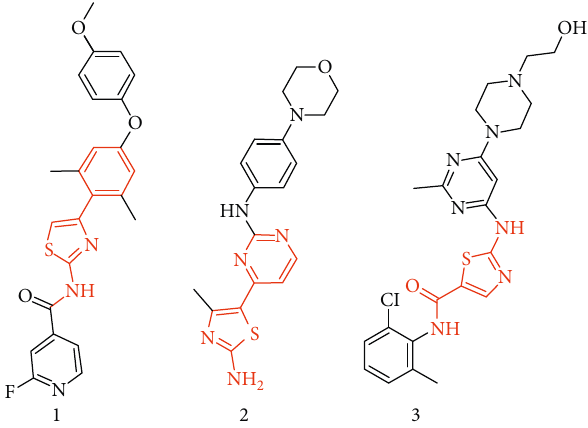
Figure 1: Structures of bioactive 2-aminothiazole derivatives.